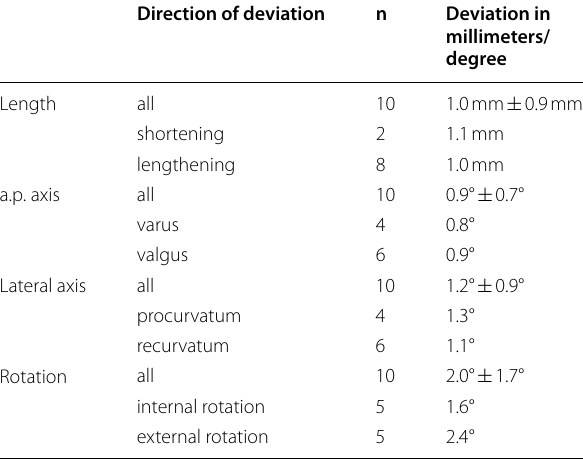
Different overall deviations are given as well as subgroups indicating the direction of malalignment. Column n demonstrates the number of cases. Overall values are given as mean standard deviationin millimeters and degrees ± Table 2 Results of the tibial 3D alignment analysis